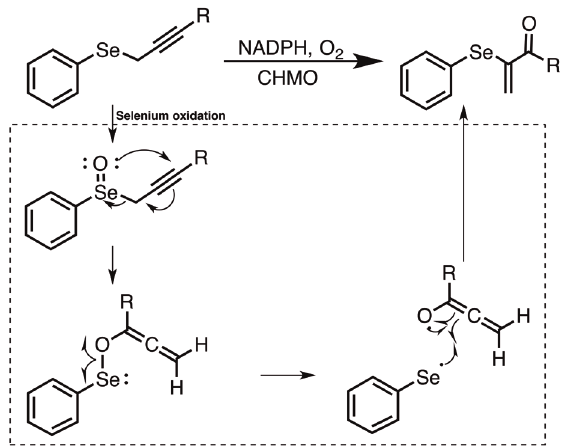
Figure 43 - α -Phenylselenoacrolein formation using cyclohexanone